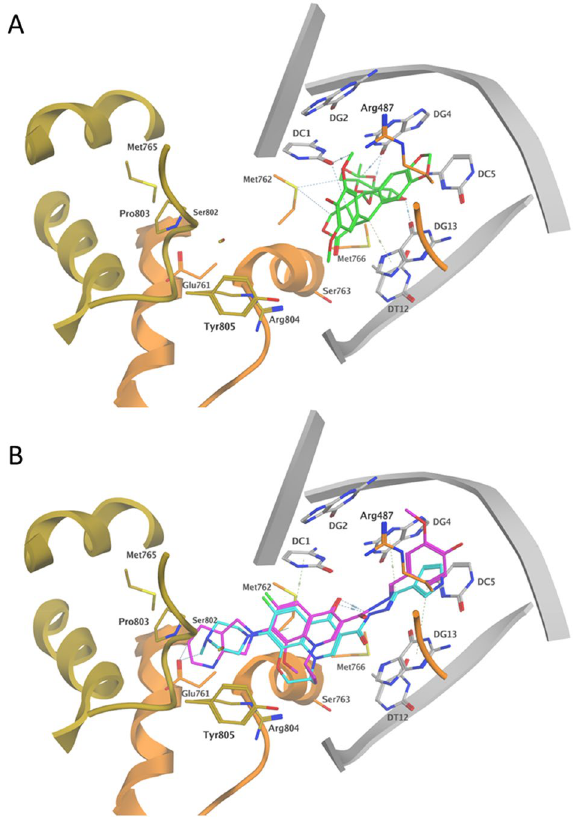
Figure 15. ( A ) 3D representation of etoposide ( 5 ) (green) in stick view bound to Topo II (chain A: orange, chain B: gold) and DNA (grey) in carton representation (PDB: 6ZY7). ( B ) 3D representation of the top docking poses of ( IIIf ) (magenta) and ( VIb ) (cyan) in stick view bound to Topo II (chain A: orange, chain B: gold) and DNA (grey) in carton representation. Generated by MOE (Molecular Operating Environment, www. chemc omp. com) 2008.10 software 47